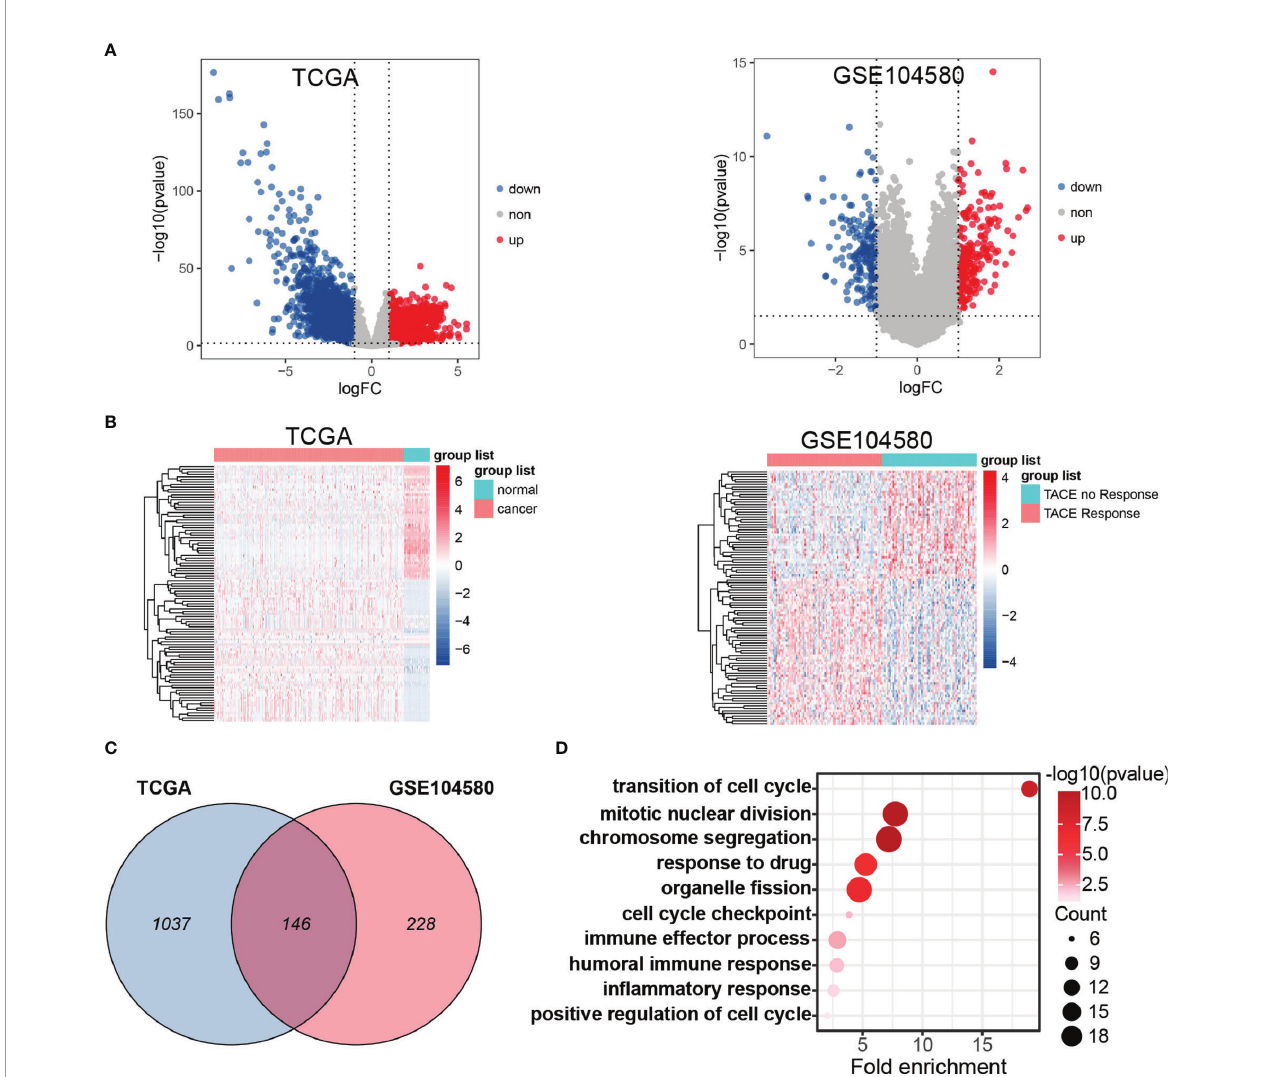
FIGURE 2 | Differential expression gene analysis. (A) Volcano plots showed differentially expressed genes (DEGs) in TCGA and GSE104580. (B) Hot plot of top 50 up- and down-regulated DEGs in TCGA and GSE104580. (C) Venn plot of common DEGs (TRGs) between TCGA and GSE104580. (D) Enrichment analysis of